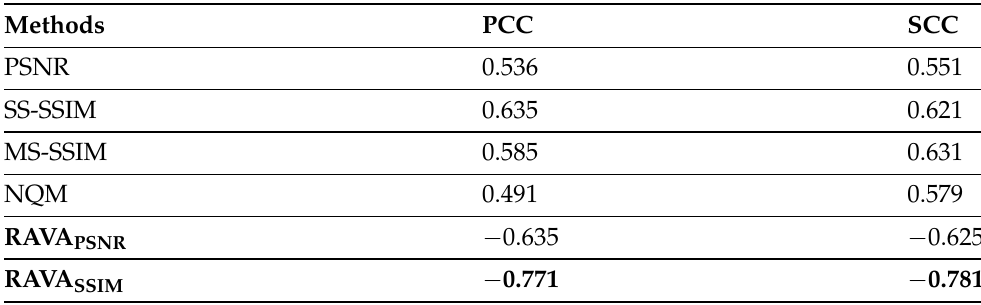
Figure 12. The performance of the pre-trained RAVA models and the existing methods on the Netflix Public Dataset. Table 7. Comparison of PCC and SCC on the Netflix Public